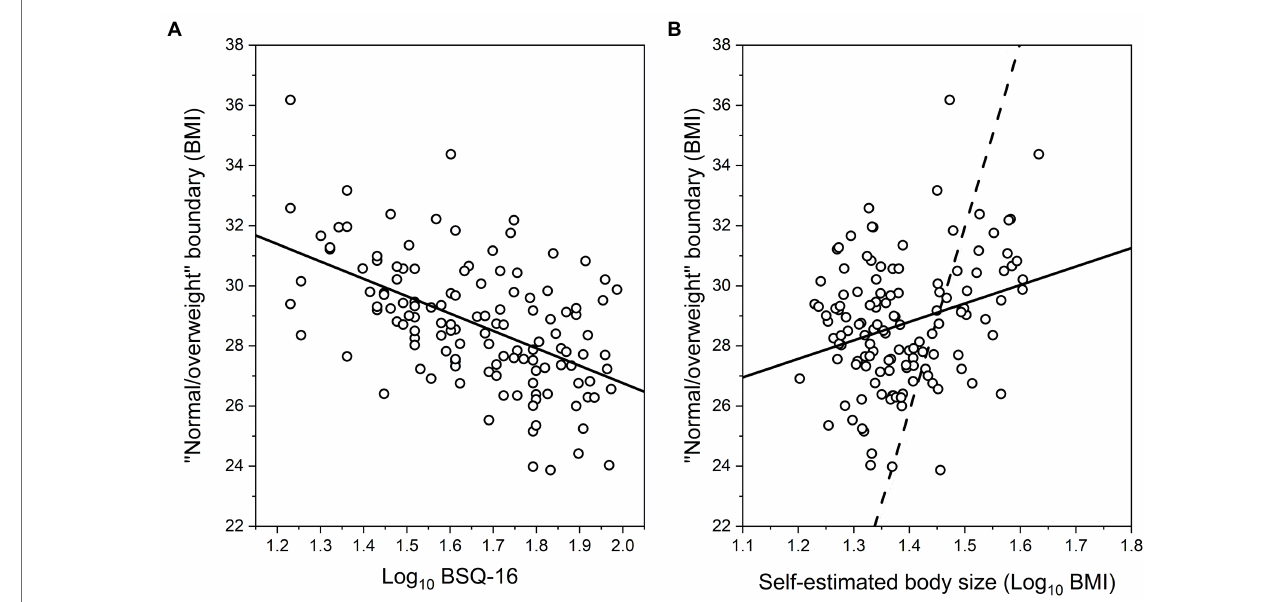
FIGURE 3 | Scatter plots of predicted “normal/overweight” boundary judgments as a function of: (A) log 10 BSQ-16, and (B) log 10 self-estimated body size, from the multiple regression model. Each case shows the regression lines through the data (solid). The dashed line in (B) represents matched responses, that is, where participants’ “normal/overweight” boundary judgments would exactly match their estimates of their own body size.